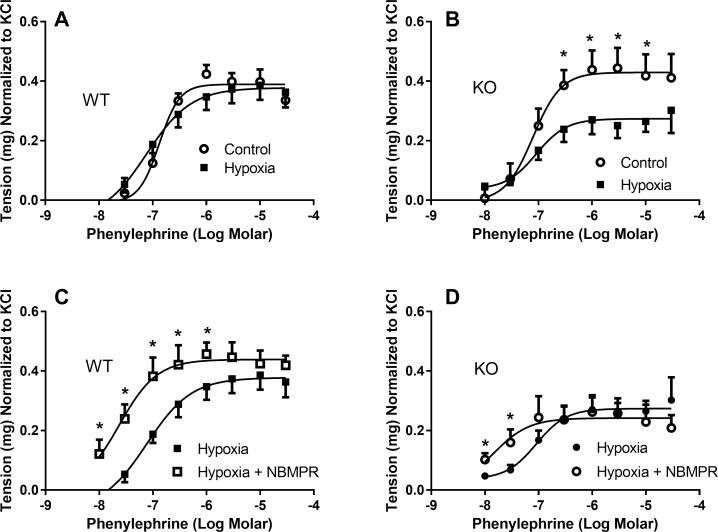
Phenylephrine dose-response curves for isolated thoracic aorta from wild-type (WT) and Slc29a1-null (KO) mice after exposure to hypoxia.Tissues were incubated for 30 min at 37˚C in KPSS buffer at resting tensions of 500 mg after which they were depolarized with 100 mM KCl. Tissues were then incubated for 60 min under either normoxic or hypoxic conditions, and then exposed to increasing concentrations of phenylephrine (Panels A and B). Panels C (WT) and D (KO) show the effect of 1 μM NBMPR on the response to hypoxia. NBMPR was administered 15 min prior to hypoxia, and then removed prior to the construction of the phenylephrine dose-response relationship. Each point is the mean ± SEM from 6 (Panel A & B) or 5 (Panel C and D) experiments. *Significant difference between treatment groups (Student’s t-test for unpaired samples, *P<0.05).